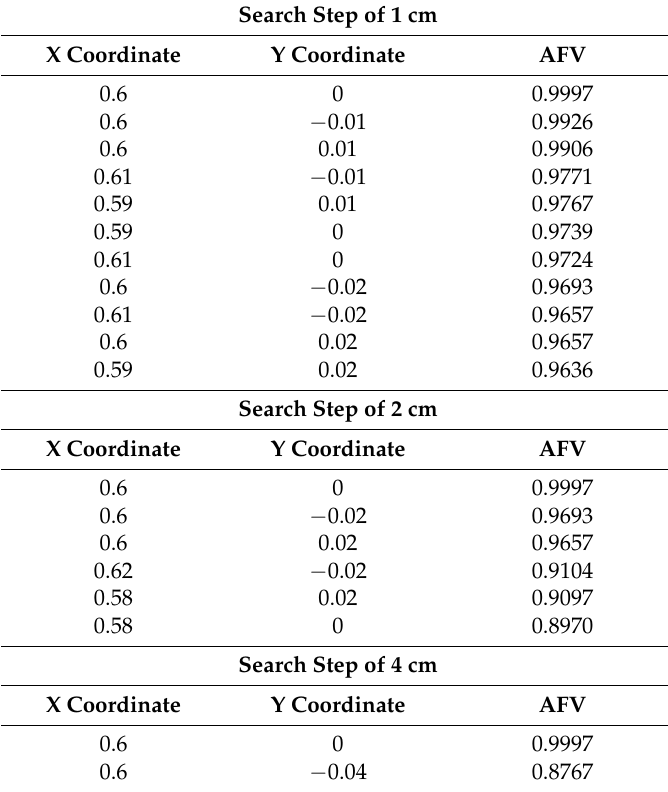
Table 2. The results of 1 m search scope under different step lengths (zero